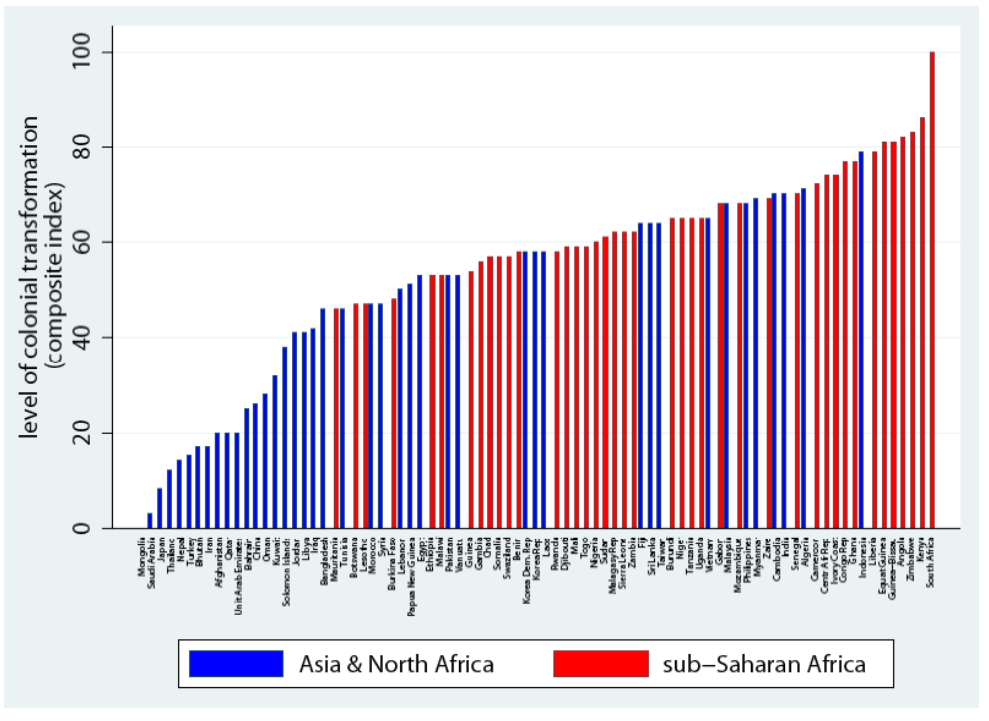
Figure 1. Total level of colonially-induced transformation in Africa and